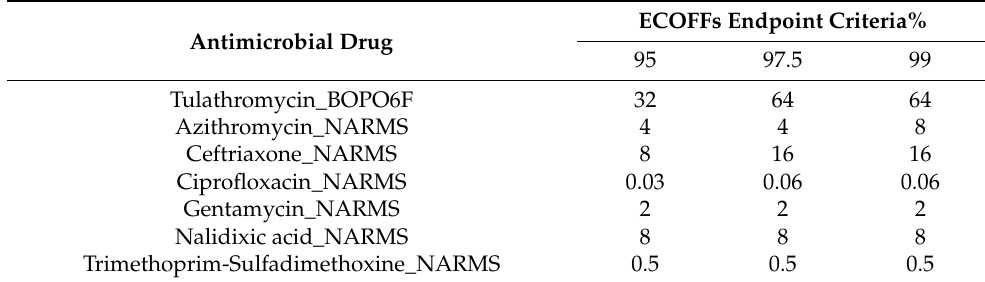
Table 4. Epidemiological cut-off points (ECOFFs) were calculated with three endpoint criteria for antimicrobial distributions meeting the criteria for the ECOFFs